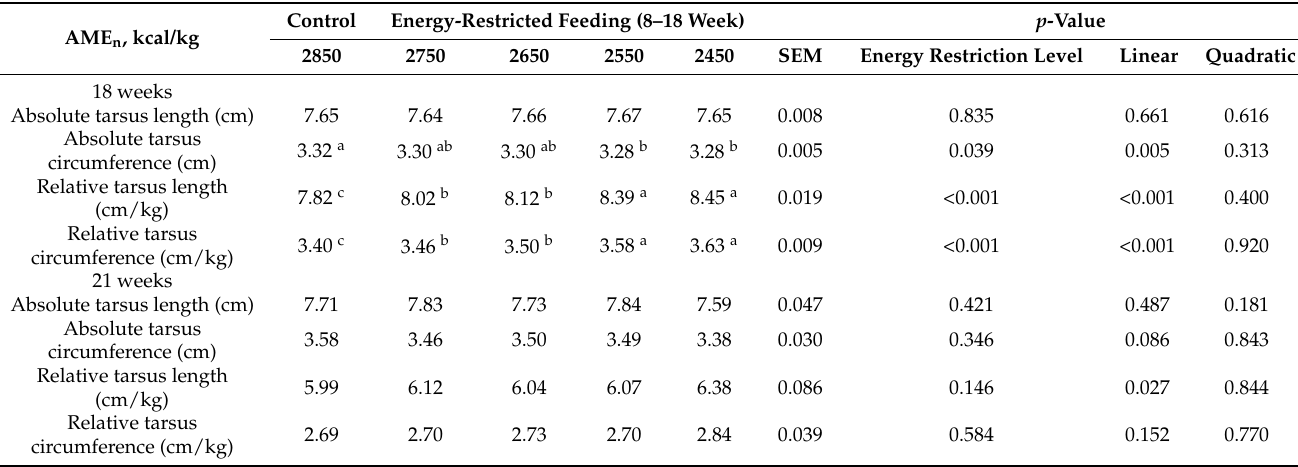
and 21 weeks of age.